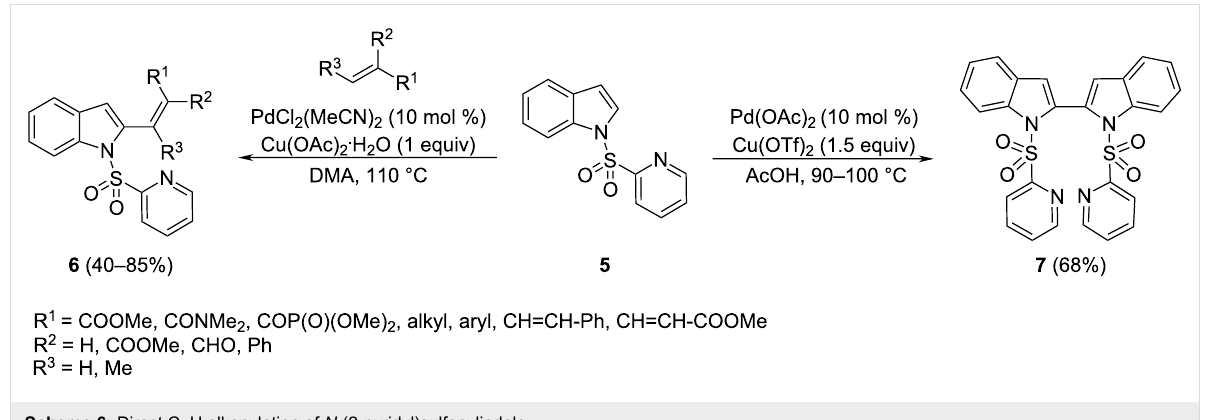
Scheme 6: Direct C–H alkenylation of N